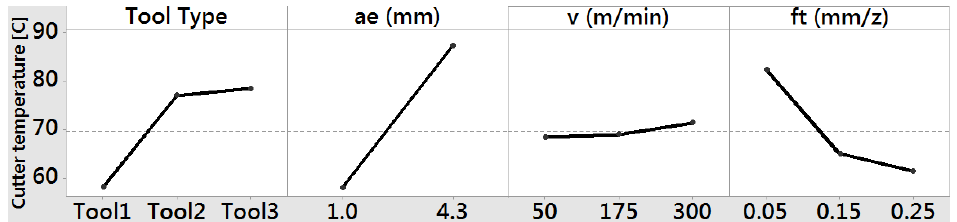
Figure 15. Main effect plot result for cutter temperature.